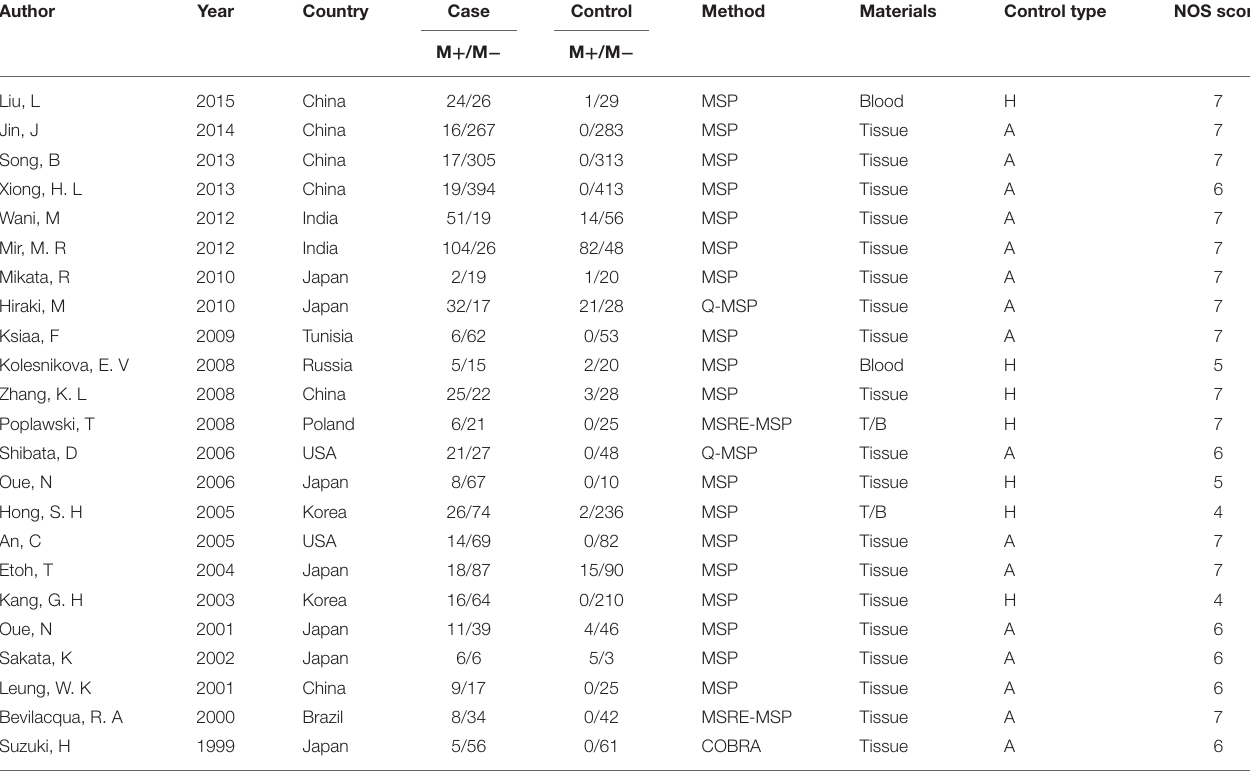
TABLE 1 | Characteristics of studies concerning hMLH1 methylation and gastric cancer